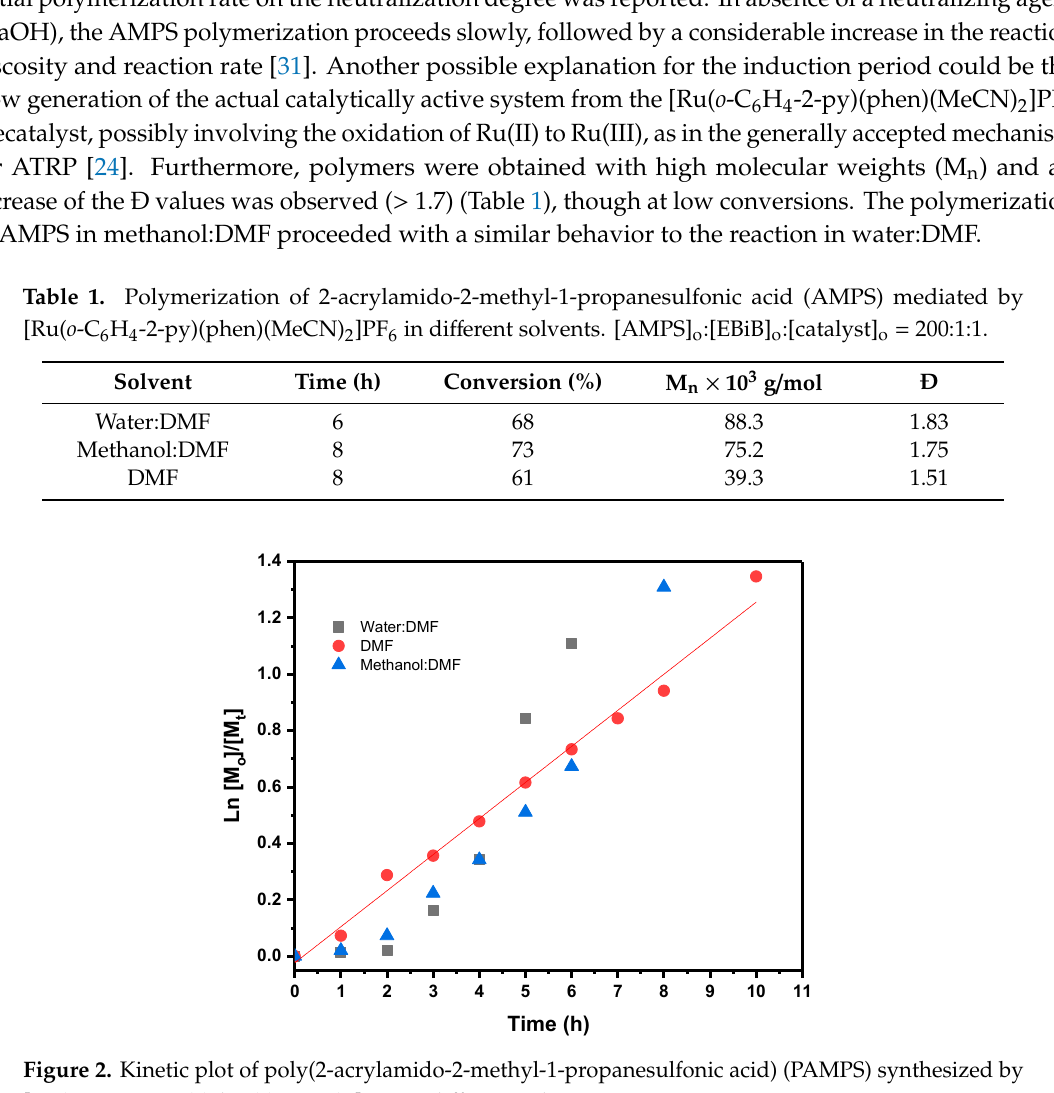
Table 1. Polymerization of 2-acrylamido-2-methyl-1-propanesulfonic acid (AMPS) mediated by